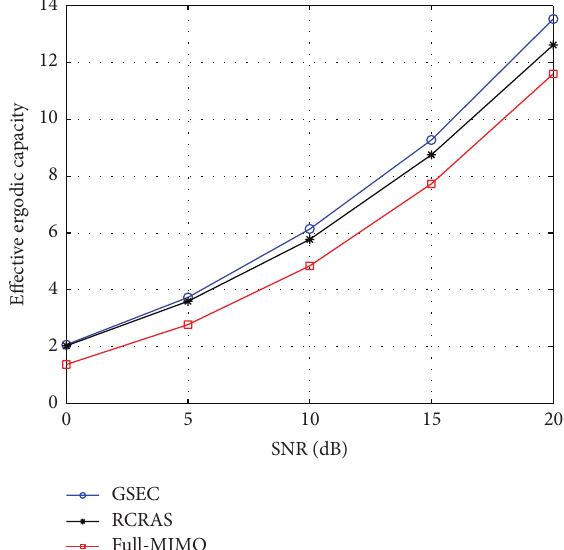
Figure 8: Effective ergodic capacity when 𝑇/Δ = 250 ( 𝑁 𝑇 = 4 , = 20 , 𝐿 = 4 , 𝐷 = 𝐷 = 𝜆 ). 𝑁 𝑅 𝑅 𝑇 𝑅